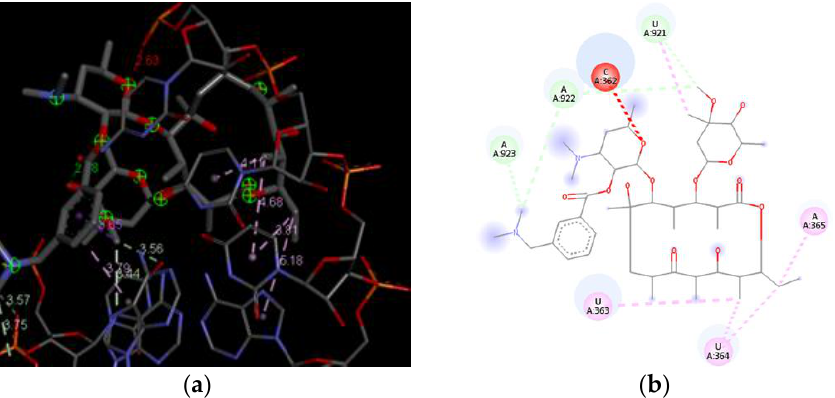
Figure 5. ( a ) Graphical representation of the obtained interactions between erythromycin B 2′-[3- (dimethylaminomethyl)benzoate] and the segment of the exit tunnel from apicoplast ribosome of P. falciparum with distances in Å ; ( b ) 2D diagram of receptor–ligand interactions.